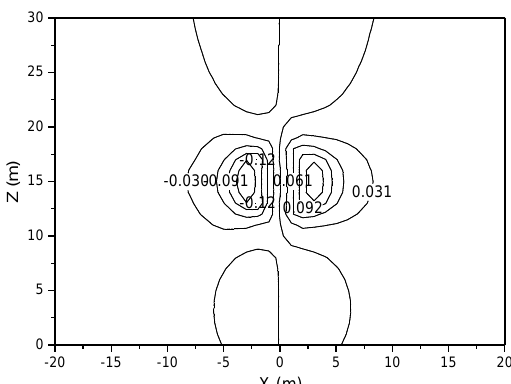
Figure 15. Horizontal displacement of stratum caused by p .